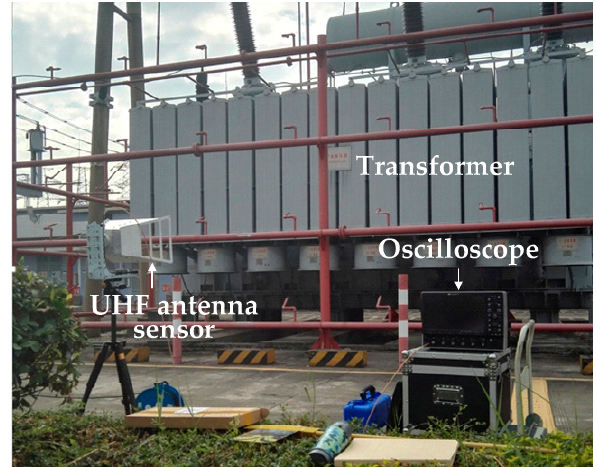
Figure 13. Field detection setup in substation.